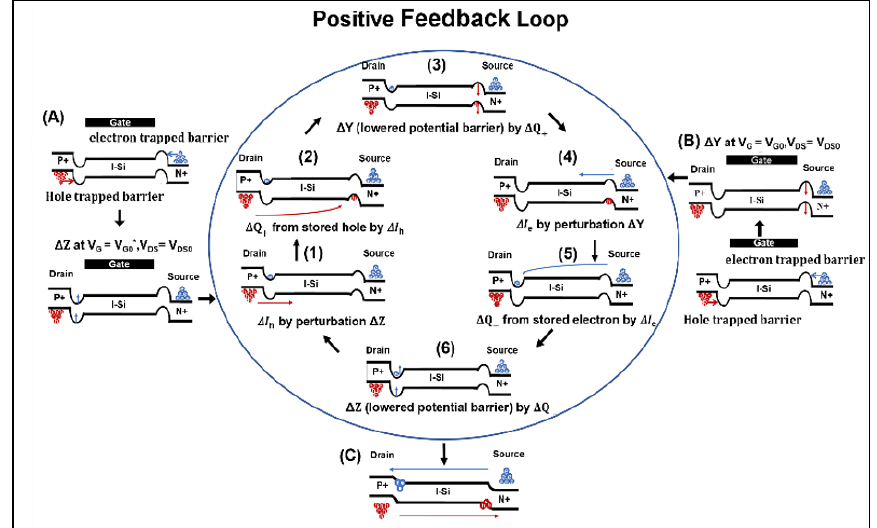
Figure 4. Illustration for positive feedback mechanism. ( A ) Collapse ( Δ Z) occurs in the potential barrier next to the P+ region through a negative gate bias (V G0* ) and drain bias (V D0 ), ( B ) collapse (ΔY) occurs in the potential barrier next to the N+ region through a positive gate bias (V G0 ) and drain bias (V D0 ), ( C ) energy band diagram of the transistor that is turned on through a positive feedback loop [63 – 65].